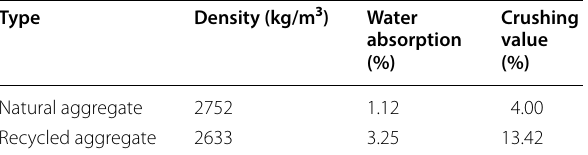
Table 1 Main physical properties of natural and recycled aggregates.